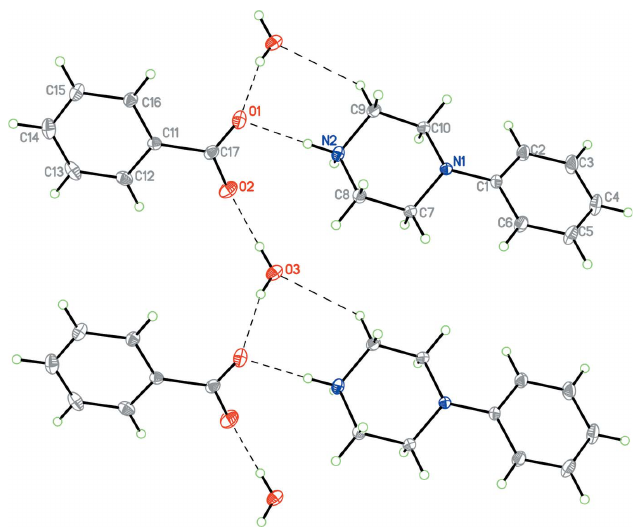
Figure 23 Partial packing diagram for 9 showing one of the two anti-parallel C 2 (6) 2 The structure of 10 contains the tosylate anion, which (cid:3) group. This results in a packing contains the non-planar –SO 3 arrangement in which N—H (cid:2) (cid:2) (cid:2) O hydrogen bonds involving the phenylpiperazinium cations and tosylate anions are arranged such that there are hydrophilic and hydrophobic (110) planes (Fig. 25). This structure also contains C—H (cid:2) (cid:2) (cid:2) (cid:2) interactions involving one of the phenylpiperazinium cations (C18–C23, Cg 1) and tosylate anions [C30 (cid:2) (cid:2) (cid:2) Cg 1 = 3.74 (3) A˚ , C30—H30 (cid:2) (cid:2) (cid:2) Cg 1 = 144 (cid:5) , symmetry operation 1 (cid:3) x , (cid:3) 1 + y , 2 (cid:3) z ].